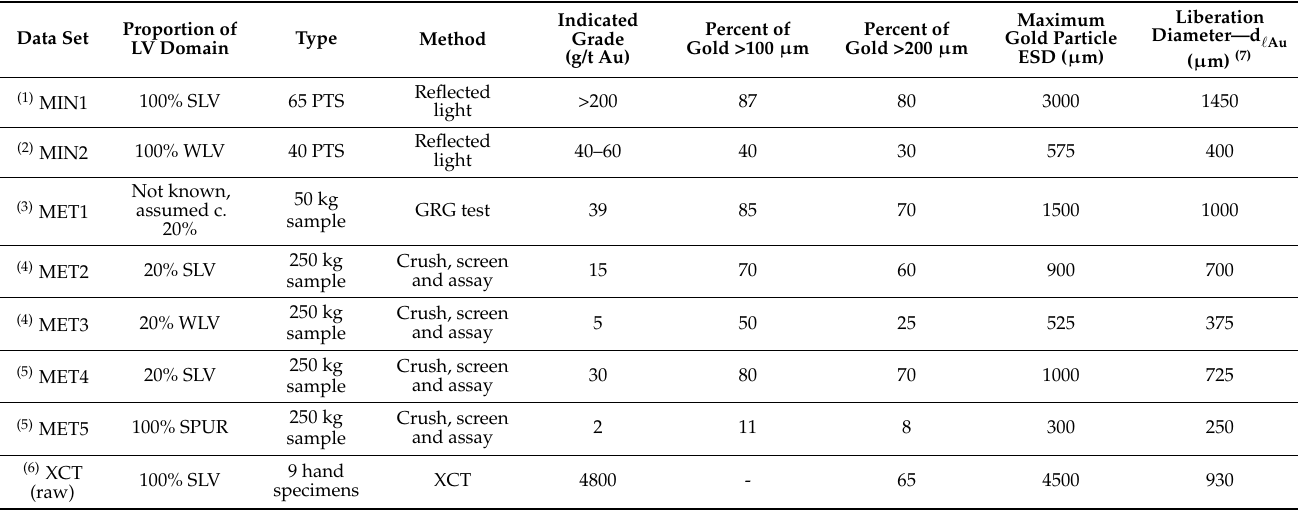
Table 12. Summary of gold particle size and liberation diameter values determined by different methods. SLV: strong laminated vein; WLV: weakly laminated vein; SPUR: spur